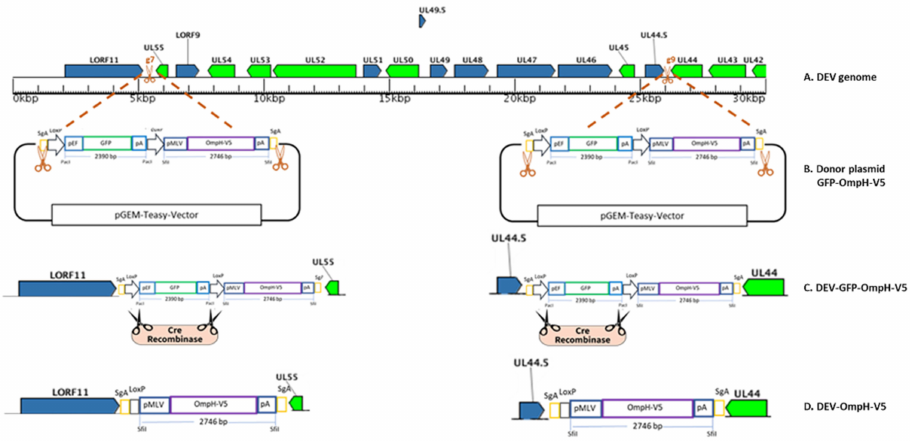
Figure 3. Schematic illustration of the recombinant DEV-OmpH-V5. ( A ) Full-length of the attenuated commercial DEV vaccine strain used in this study. The scissor icon represents the gRNA targeting sites in the intergenic region of DEV genome (UL55-LORF11 and UL44-44.5) for OmpH-V5 gene insertion via CRISPR-Cas9 base gene knock-in. ( B ) Two portions of the genome selected to insert fragment of the GFP and the OmpH-V5 expression cassettes released by Cas9/sgA cleavage from donor plasmid. ( C ) The recombinant DEV expressing the reporter GFP and OmpH-V5 before the GFP gene is excised by Cre recombinase. ( D ) After GFP excision, the recombinant vaccine candidate terms are DEV-OmpH-V5 of UL 55-LORF11 and